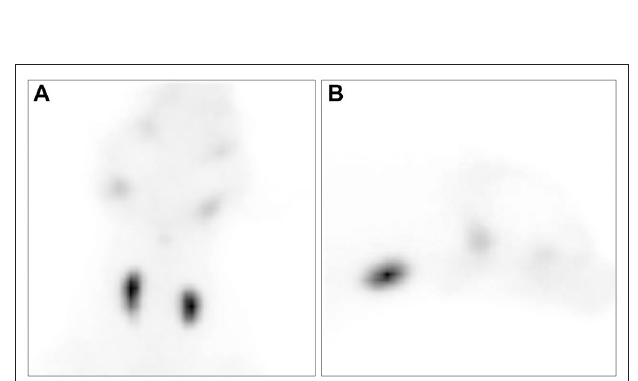
FIGURE 3 | Ventral (A) and right lateral (B) views of thyroid scintigraphy in the dog with a goiter caused by iodine deficiency. All images were acquired 40min after the injection of technetium-99m pertechnetate. Markedly increased uptake of technetium-99m pertechnetate is observed in the thyroid mass.